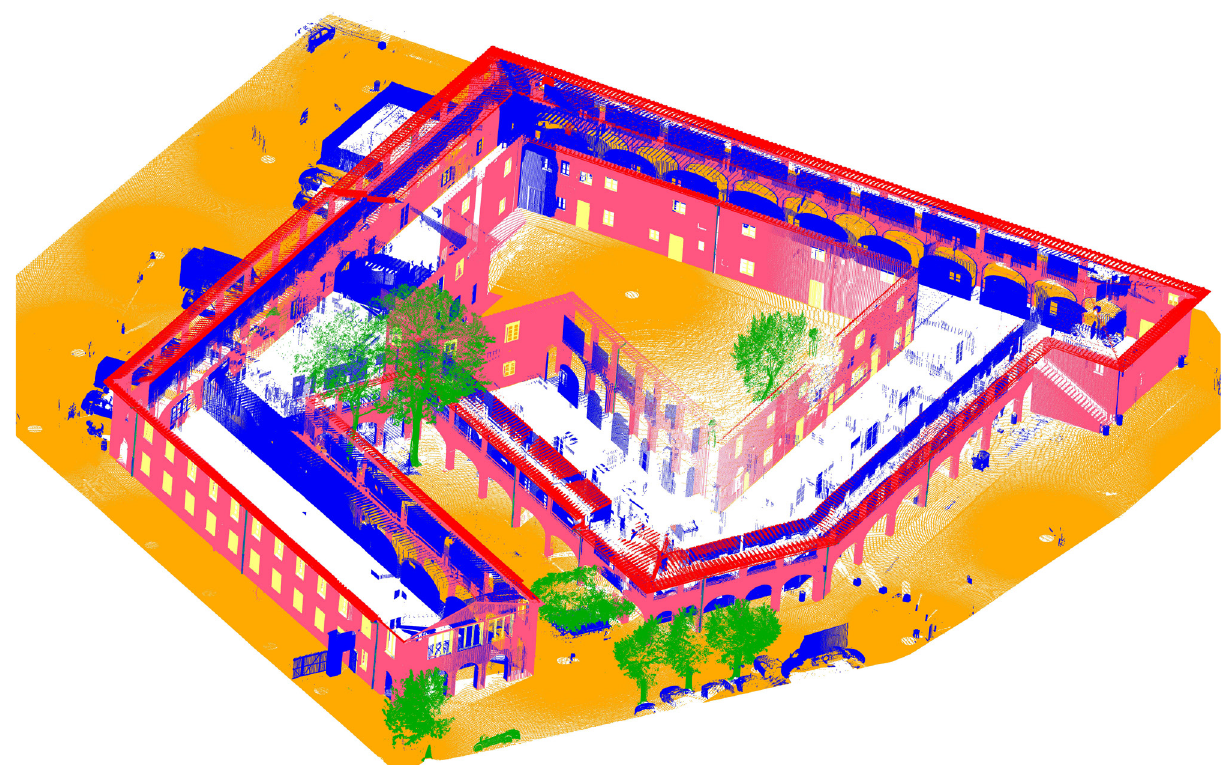
Figure 10. Test about data segmentation on a building inside the